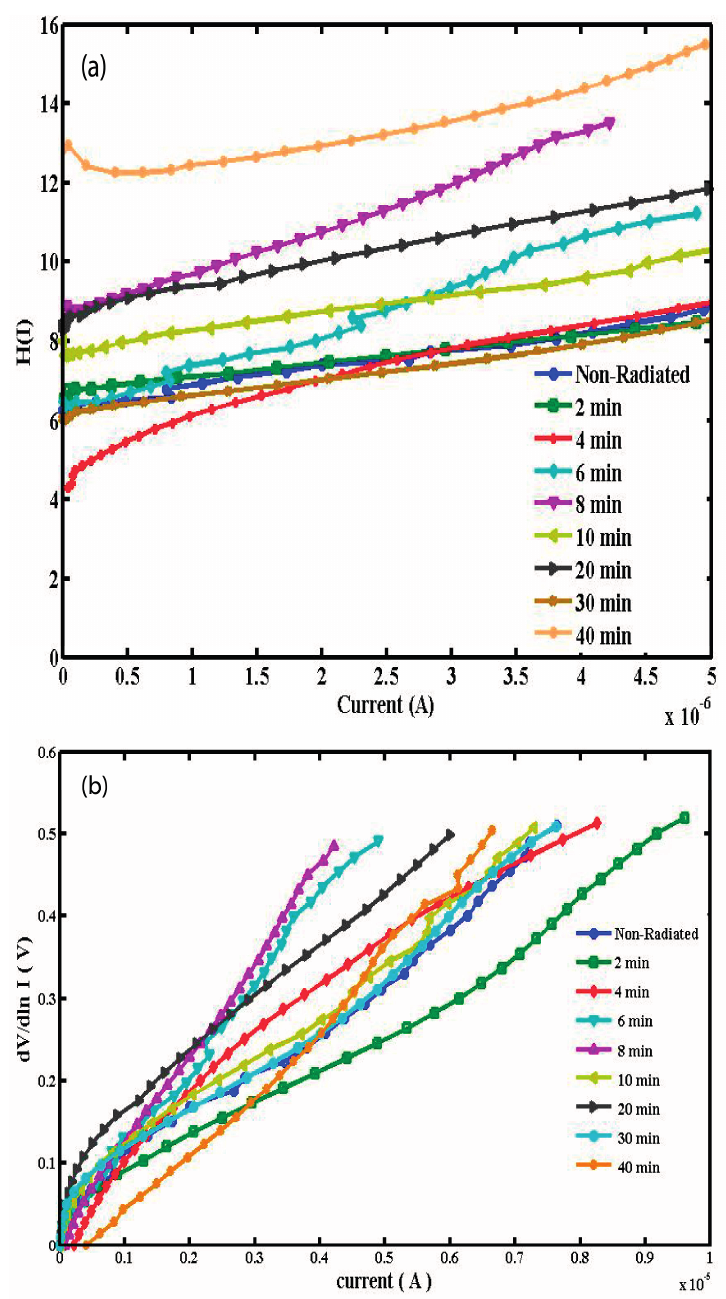
Figure 5. H(I) and dV/d(ln I) versus I graphs obtained from forward bias I-V characteristics of Al/DNA/Si/Al Schottky junction